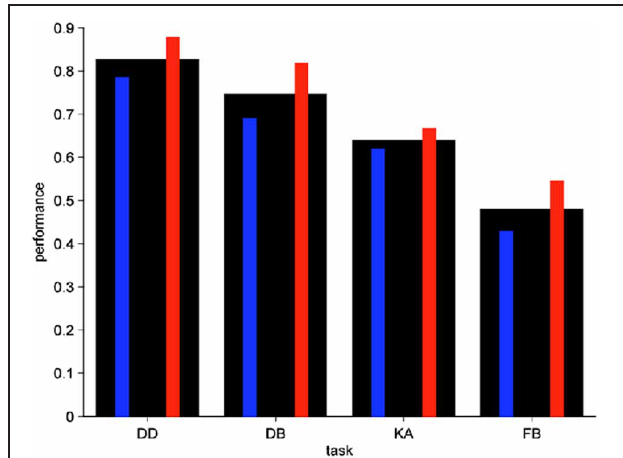
FIGURE 2 | Kids’ average performance. Fraction correct, mean, thick black bars; boys, left thin blue bars; girls, right thin red